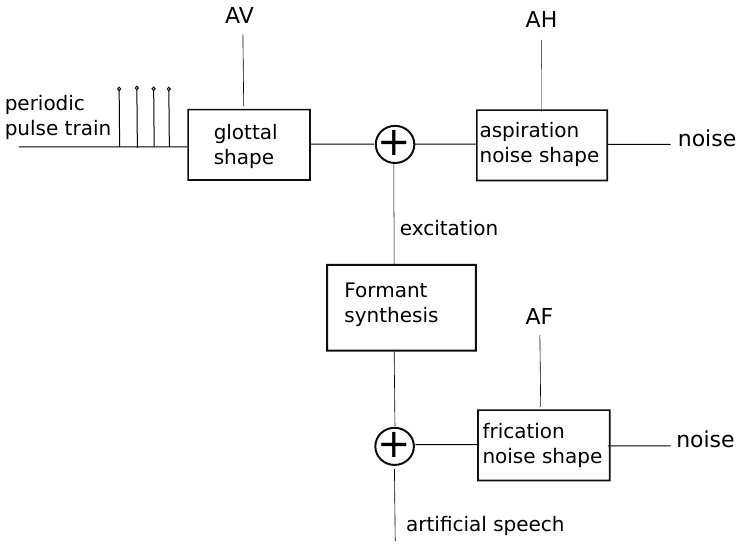
Figure 9. Mixed excitation sequence.